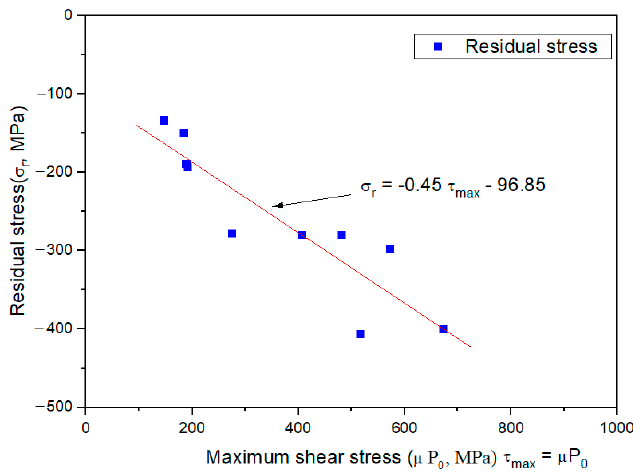
Figure 28. Relationship between residual stress and maximum shear stress.